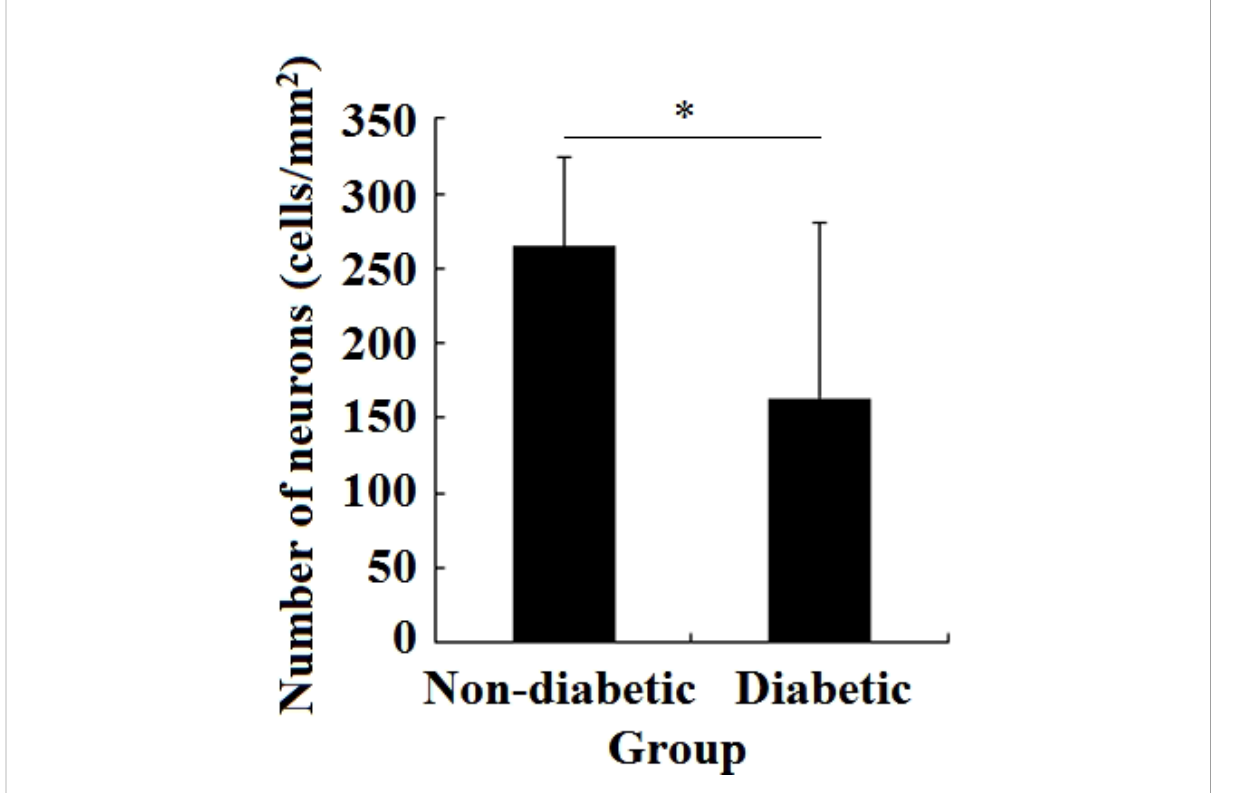
FIGURE 2 Changes in the amount of Girdin expression in the non-diabetes brain tissue and diabetes brain tissue. *P < 0.05.